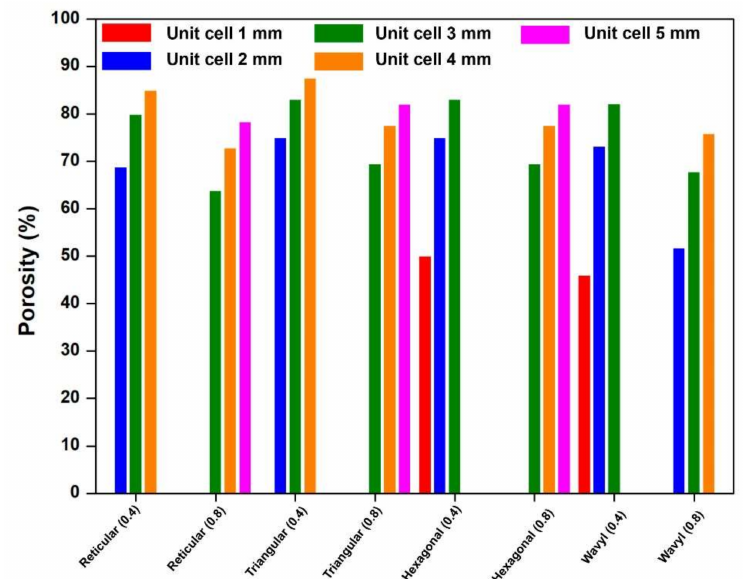
Figure 2. Theoretical porosity of different lattice scaffolds. Porosity of each CAD model obtained by measuring the occupied volume of each